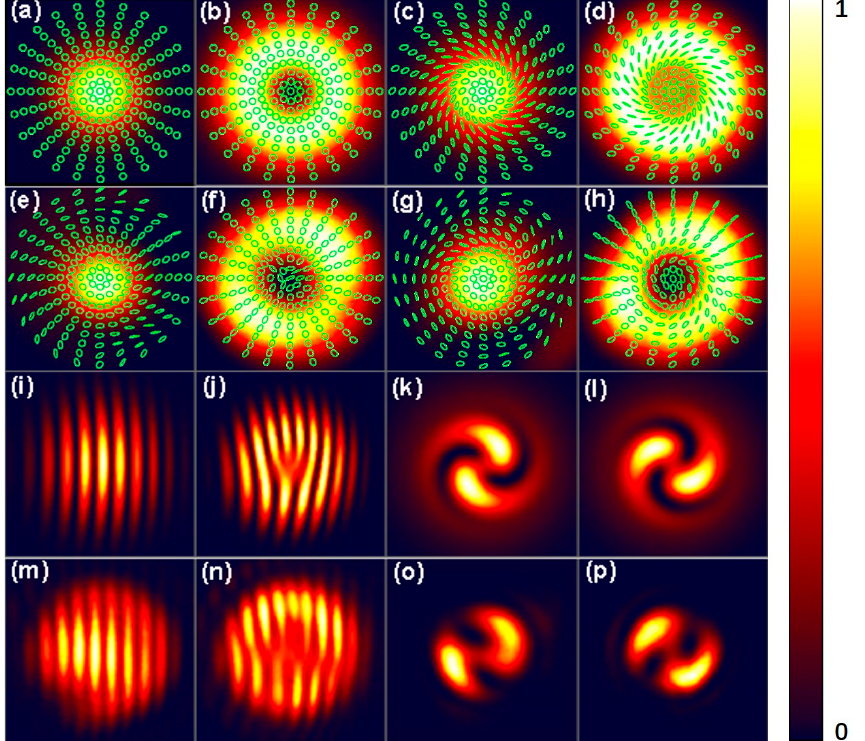
Figure 6. Polarization and intensity distributions of the generated vector vortex beams. ( a – d ) The theoretical polarization and intensity distributions for the points ( 0,0,1 ), ( 0,0,−1 ), ( 0,− √2/2,√2/2 ), and ( 0, √2/2,−√2/ 2) on the hybrid-order Poincaré sphere in order from left to right. ( e – h ) The corresponding experimental results. ( i – l ) The theoretical interference patterns of two poles and intensity distributions of the elliptically polarized vortex beams behind a horizontal polarizer. ( m – p ) The corresponding experimental results.